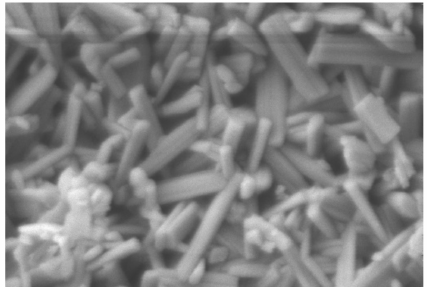
Figure 3. SEM image of rod-like morphology of M1 MoVNbTeO x catalyst.